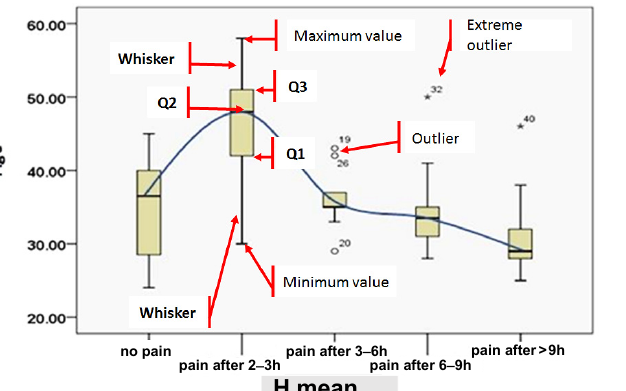
Figure 6. The best correlation coefficient vs. the response (perceived neck pain/no perceived neck pain) to angle_1, area, and contrast.